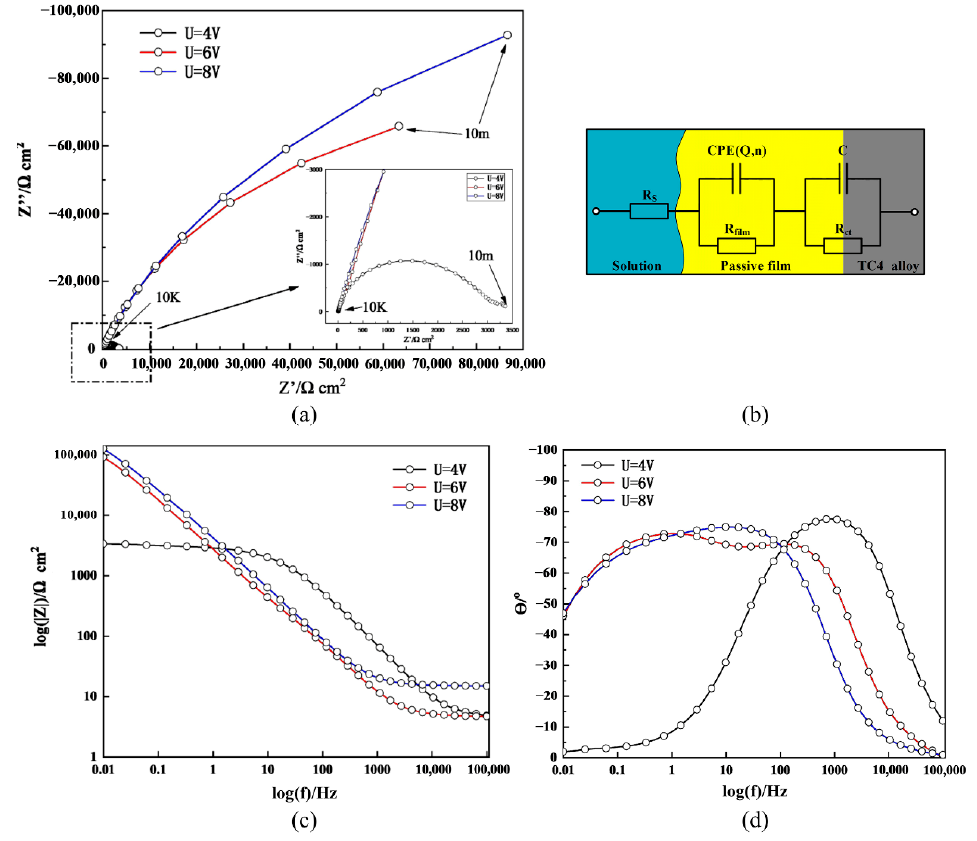
Figure 5. Electrochemical impedance spectroscopy (EIS) plots for TC4 in 10% NaNO 3 solution. ( a ) Nyquist plots; ( b ) electrical equivalent circuit (EEC) used to fit the EIS data; ( c ) Bode impedance plots; ( d ) Bode phase plots.